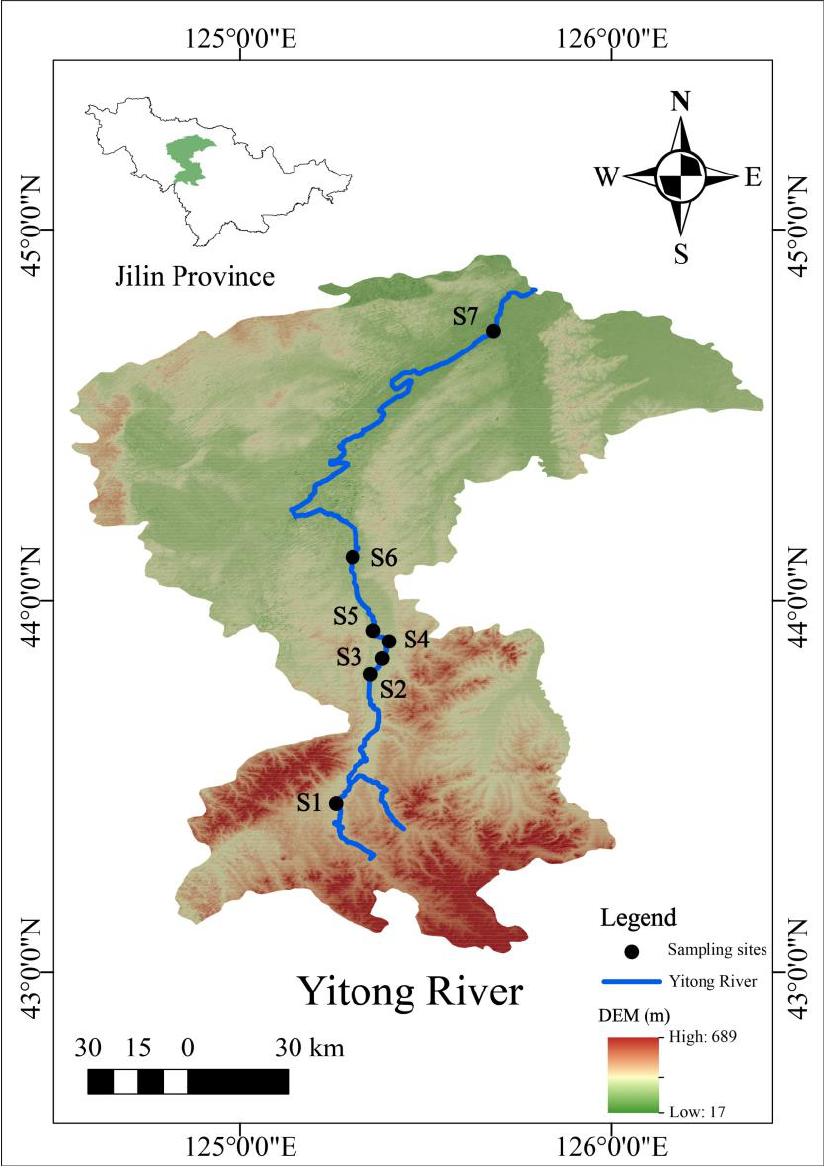
Figure 1. Location of the Yitong River and sampling sites.